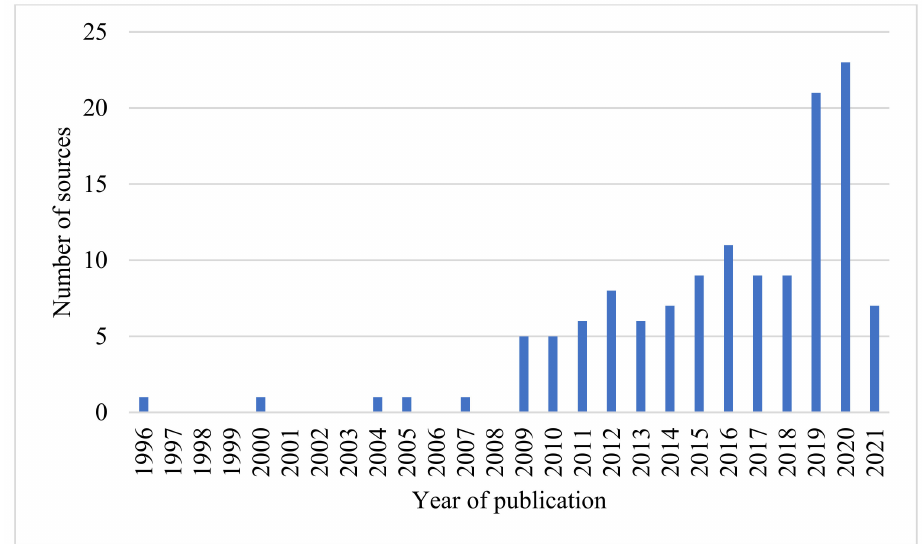
Figure 4. Classification of sources by year of publication (created by the